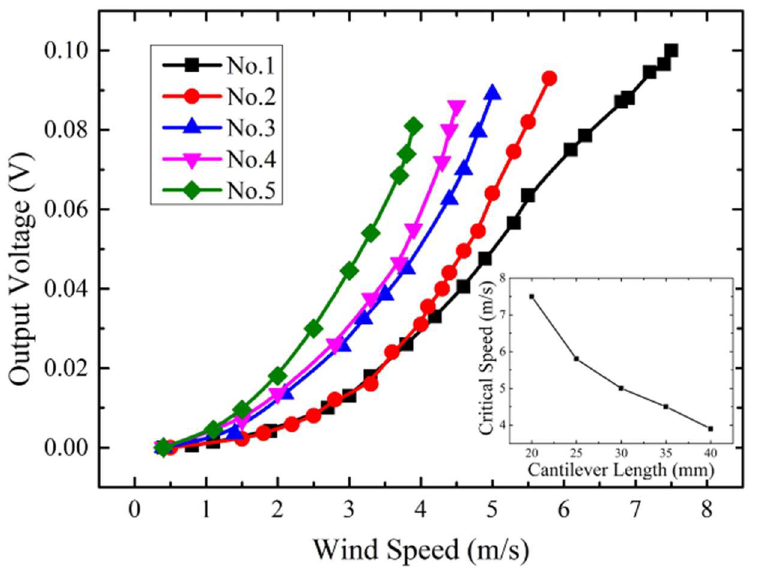
Figure 4. Experimental output voltage versus wind speed characteristics for prototypes with different lengths.